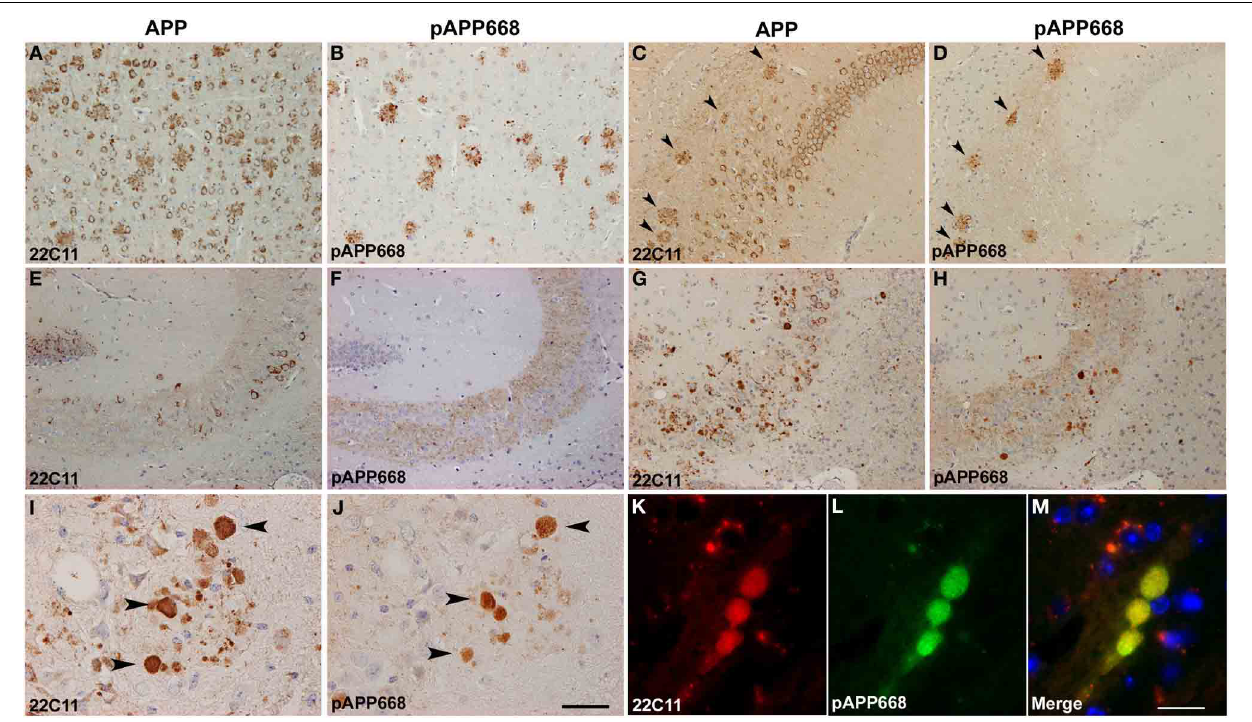
FIGURE 3 | Comparison between APP (22C11) and phosphorylated APP (pAPP668) staining patterns using parallel sections in different brain regions of APP/PS1KI ho mice of different ages. Whereas 22C11 stains dystrophic neurites as well as cell bodies, pAPP668 exclusively stains axonal compartments in cortex ( A,B : 2m),